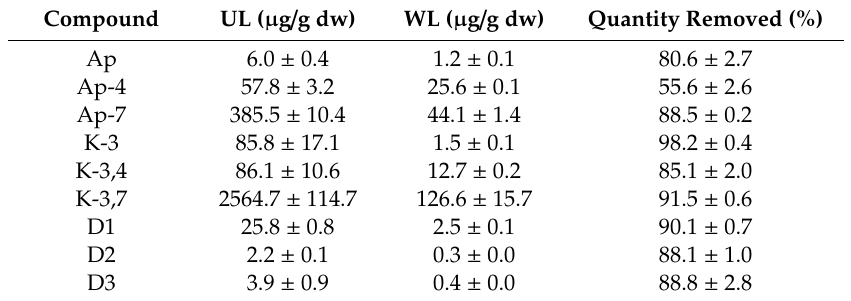
Table 1. Amount of flavonoids and diterpenes ( µ g / g dry weight) present in untreated leaf litter (UL) and washed leaf litter (WL). Values are the mean of three replicates ± standard